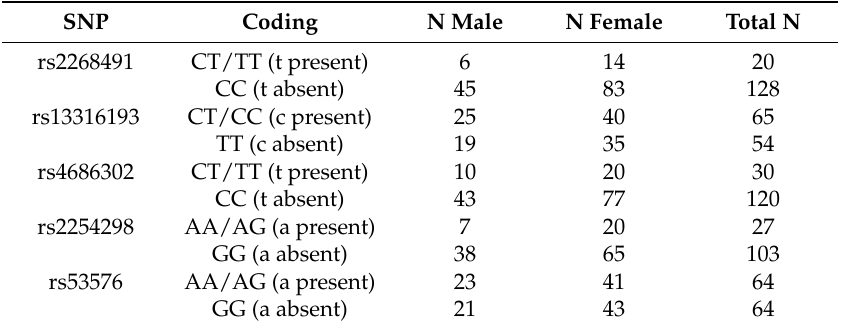
Table 2. Distribution of OXTR SNPs for the present sample coded as presence or absence of the minor allele. SNP Coding N Male